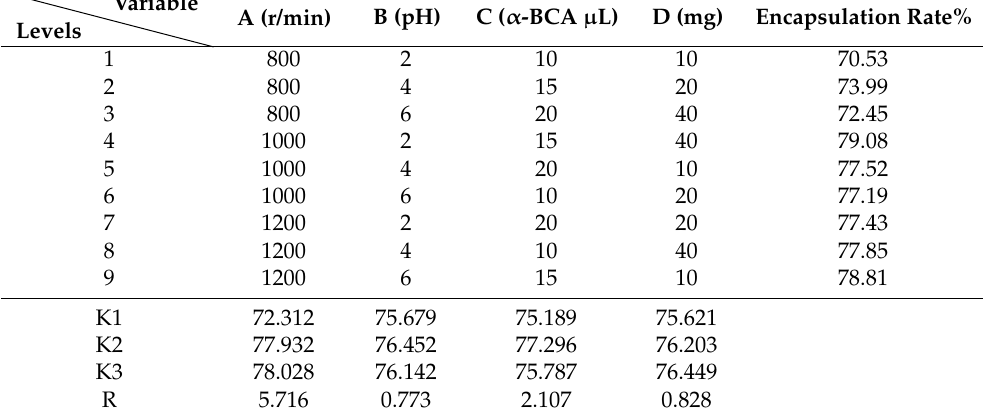
Table 3. Results of the orthogonal test. The orthogonal experimental design table L 9 (34) was used to optimize the preparation, and the most suitable were screened for the encapsulation rate as shown by the index.